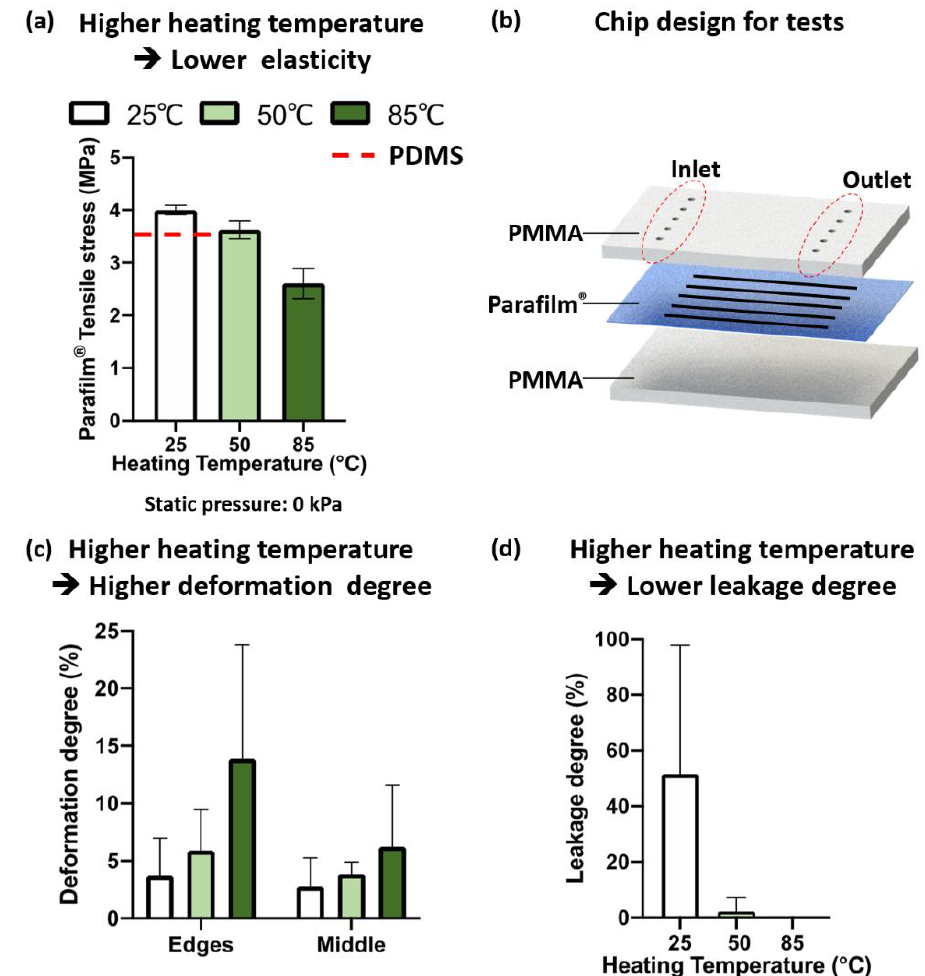
Figure 3. Effects of temperature and pressure on Parafilm ® mechanical properties and deformation. ( a ) The higher the heating temperature, the lower the ultimate tensile stress of Parafilm ® . Width of Parafilm ® specimens: 15 mm. No pressure was applied to the Parafilm ® specimens. ( b ) Chip design for leakage and deformation tests. Deformation degree ( c ) and leakage degree ( d ) of Parafilm ® microchannels with different heating temperatures. Static press pressure: 33.3 kPa.